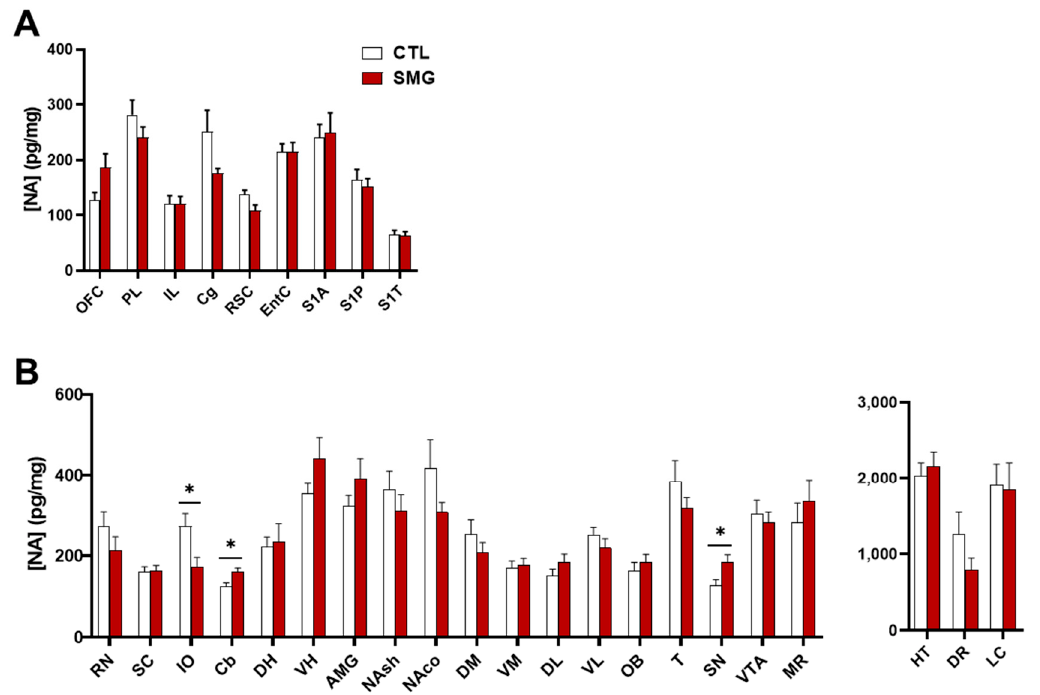
Figure 3. Effect of the SMG on NA tissue content in the brain. NA concentration in pg/mg of tissue for each group is shown in sampled cortical ( A ) and sub-cortical ( B ) brain regions. The values in HT, DR, and LC were separated from the other structures due to the higher levels of NA. All data are presented as mean ± sem ( n = 12 rats/group). * p < 0.05, significant difference between SMG and CTL group (Mann–Whitney test).